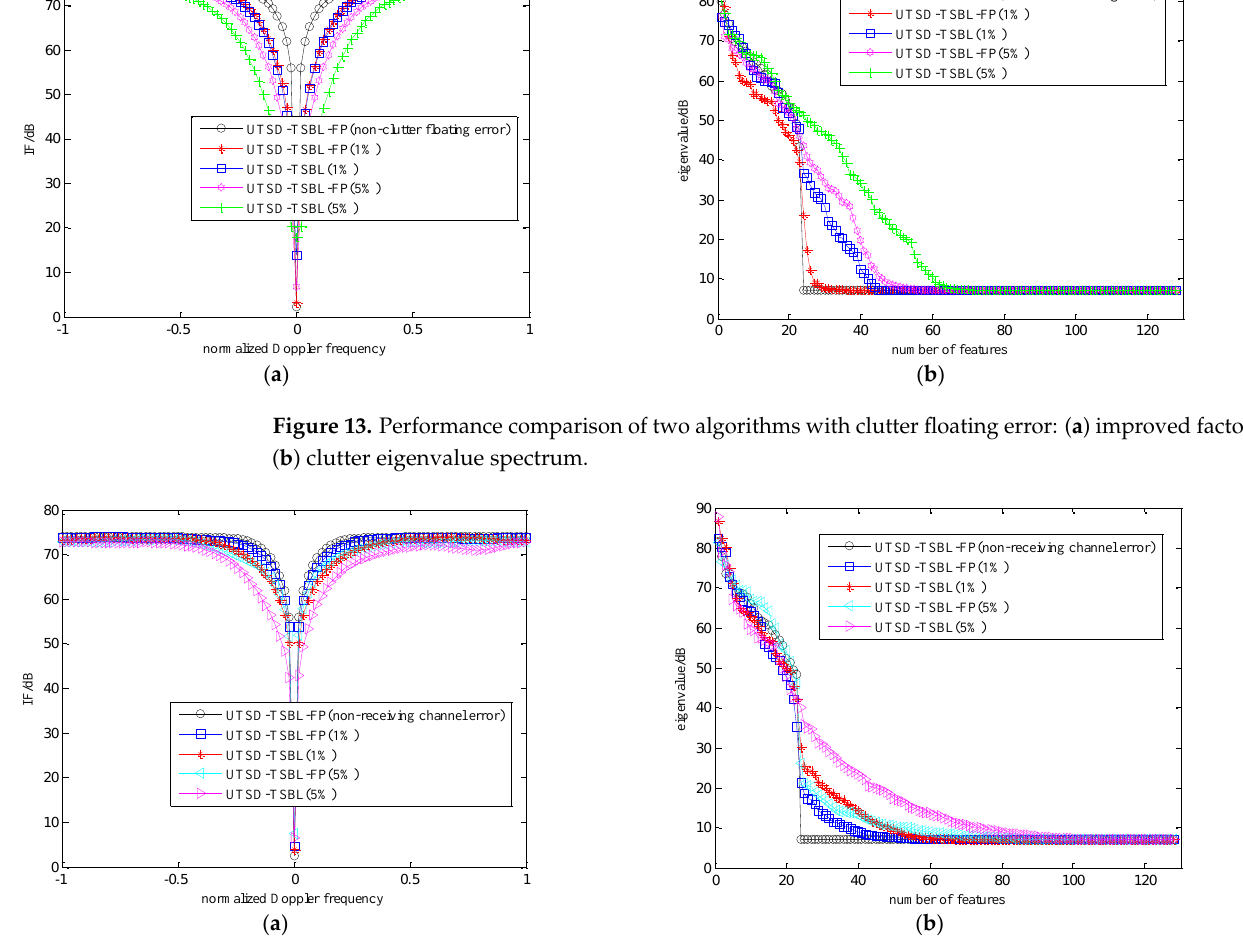
Figure 14. Performance comparison of two algorithms with receiving channel error: ( a ) improved factor; ( b ) clutter eigenvalue spectrum.